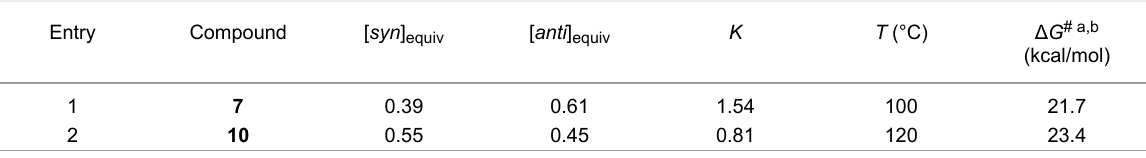
Table 3: Rotational barriers of compounds 7 and 10